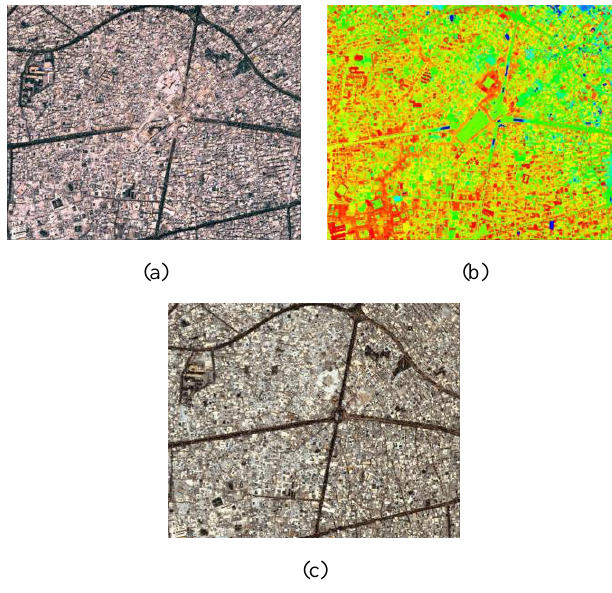
Figure 4. The structure of feature extraction from the shallow layers (Amirkolaee and Arefi, 2019a). Pleiades image with 0.5 meter resolution and a LiDAR data which is resampled to a pixel size of 0.5 meter. The provided data in 2006 only contains a pan-sharpened QuickBird image with 0.5 meter resolution. The satellite images and LiDAR data of the study area are represented in Figure 5.